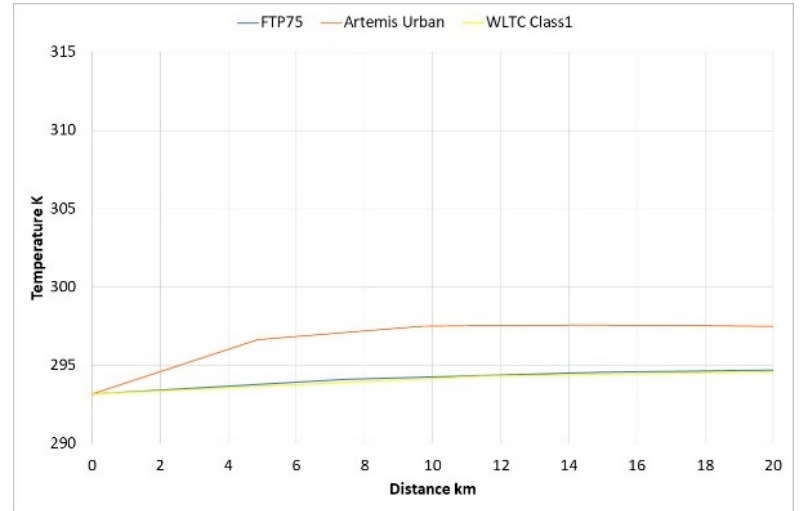
Figure 16. Temperature of the battery for the Artemis Urban, FTP75 and WLTC Class 1 with the hybrid storage. These input data can be then used to calculate the degradation of the battery, and to quantify the benefits of the adoption of the hybrid storage in terms of cycle life.